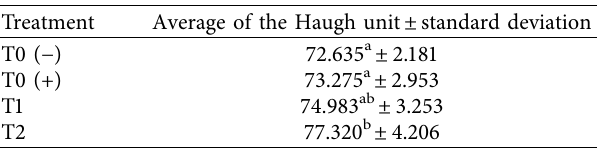
Table 3: Average of the Haugh unit in quails ( Coturnix coturnix japonica ).